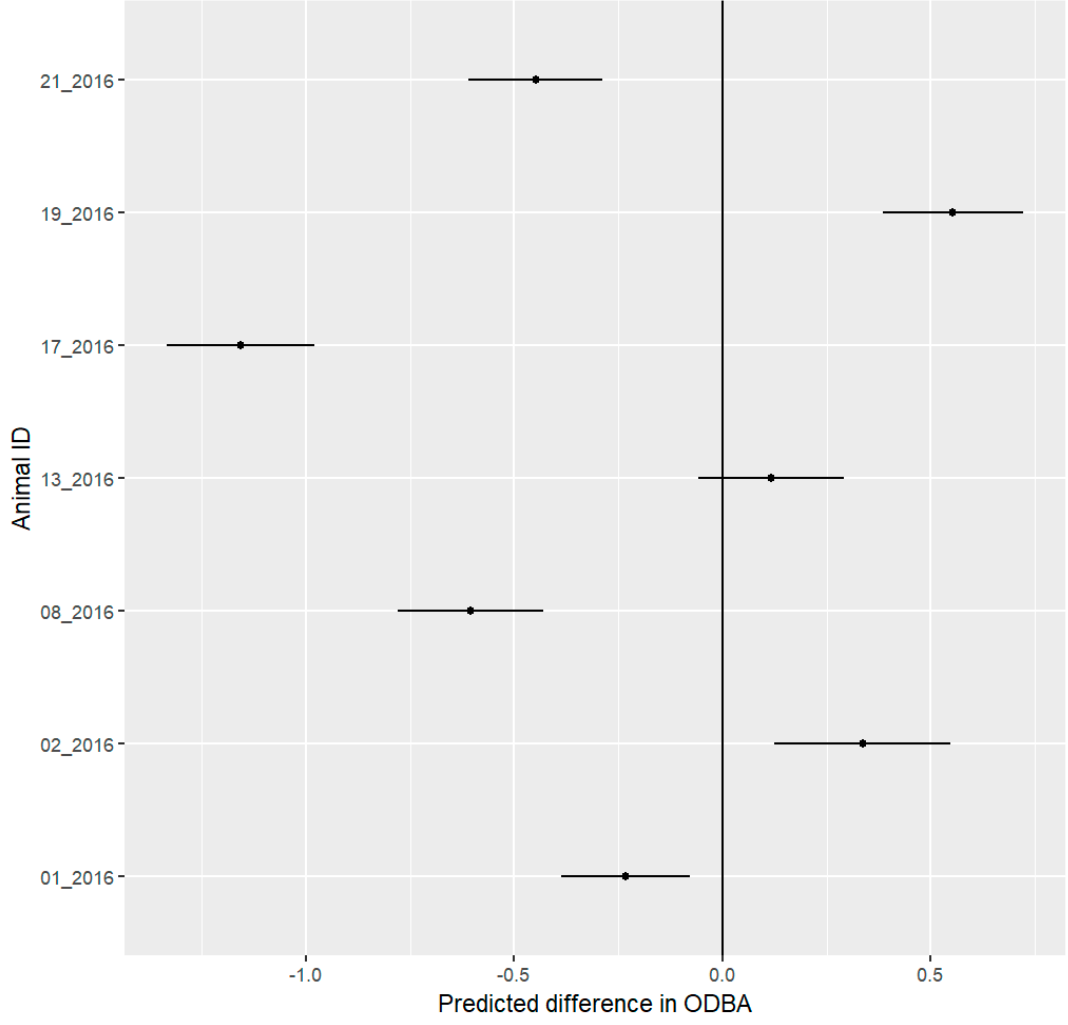
Figure 6. Mean predicted values with 95% confidence interval for di ff erences in daily overall dynamic body acceleration (ODBA) of seven hedgehogs between the pre-festival and festival phases. The predicted di ff erence represents changes in ODBA (values were transformed using the z-score). Negative values represent a decrease in the ODBA during the festival, while positive values represent an increase during the festival. These di ff erences represent changes in the magnitude of standard deviations. We consider all di ff erences to be significant where the confidence interval does not include 0. Four out of seven individuals showed a significant decrease in the ODBA, while two other hedgehogs showed a significant